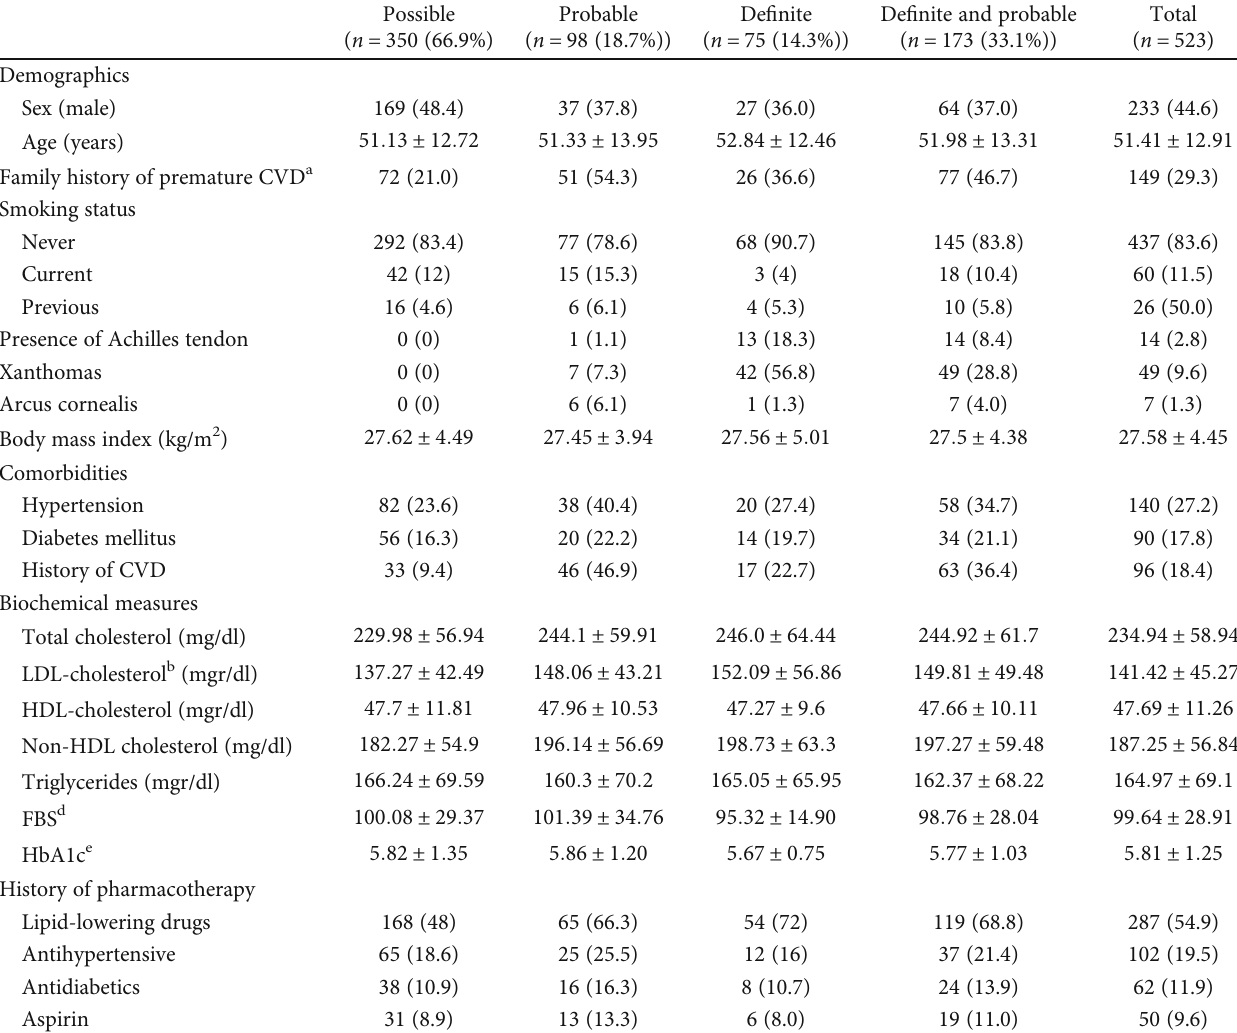
Table 1: Baseline characteristics of subjects with familial hypercholesterolemia by Dutch Lipid Clinic Network diagnosis. Possible ( n = 350